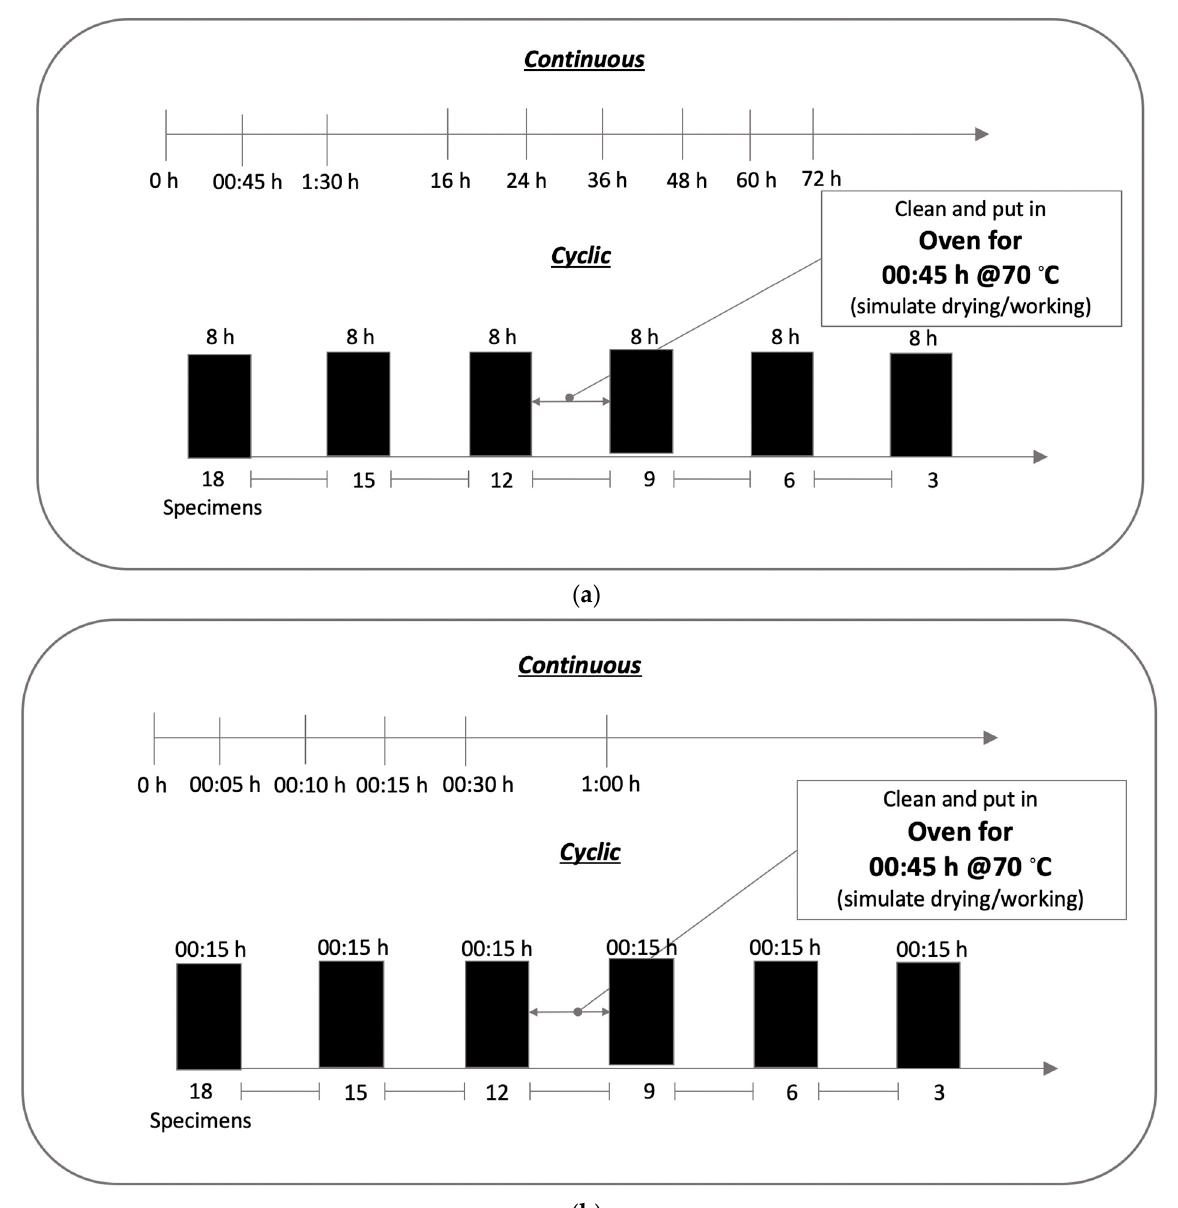
Figure 3. Continuous and cyclic test plan for petroleum oil and ultrasound fluid. ( a ) Petroleum oil. ( b ) Ultrasound fluid. Table 3. Ageing guidelines for different mediums, based on the compression shear strength of aluminium single lap joints of aged specimens against unaged specimens. Obtained from the adhesive’s